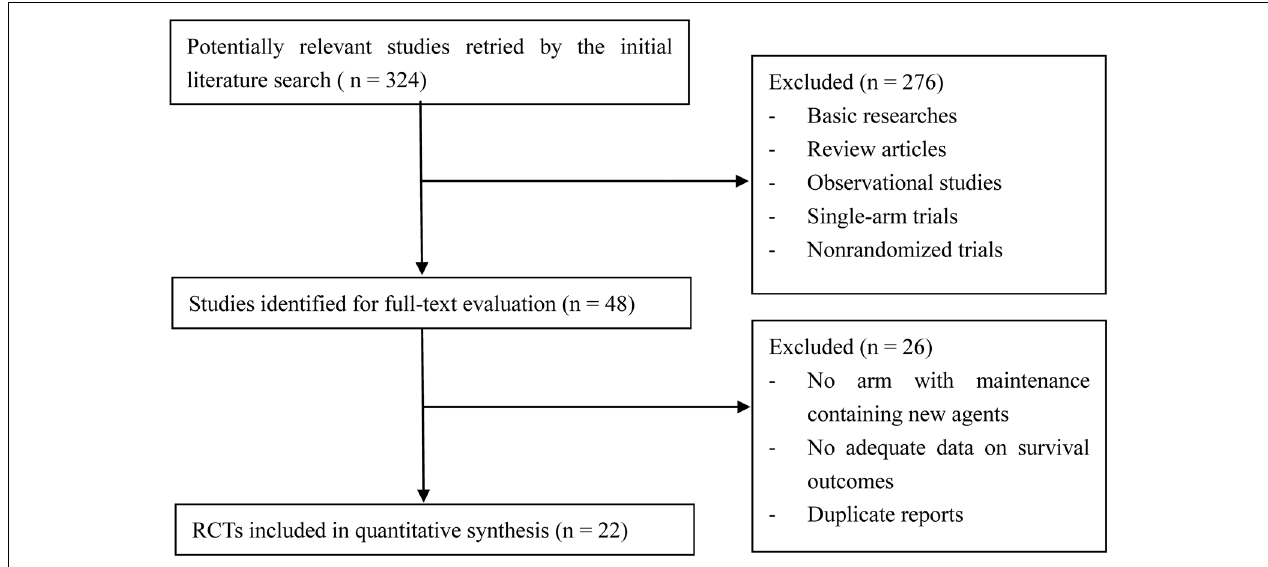
FIGURE 1 | Flow diagram of literature search and study selection. Among 324 hits retrieved by initial search, 22 RCTs were finally identified